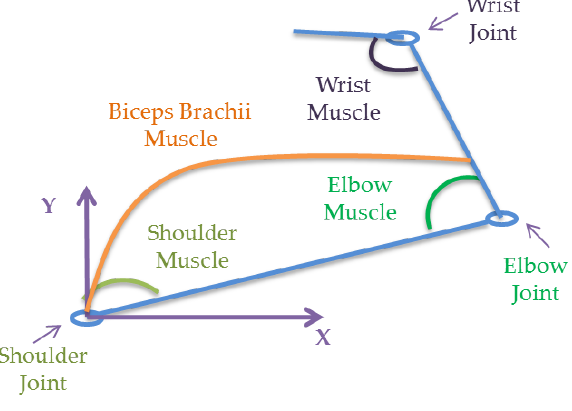
Figure 3. Representation of the hand at musculoskeletal level. Table 1. Stiffness and damping coefficients of the muscles.